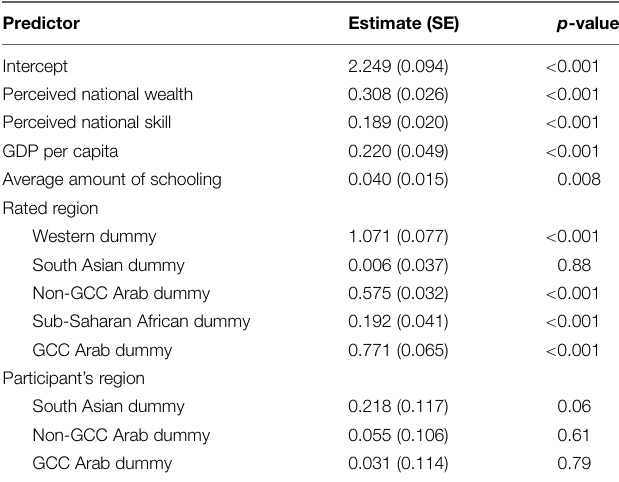
TABLE 5 | Coefficients from model testing main effects on expected